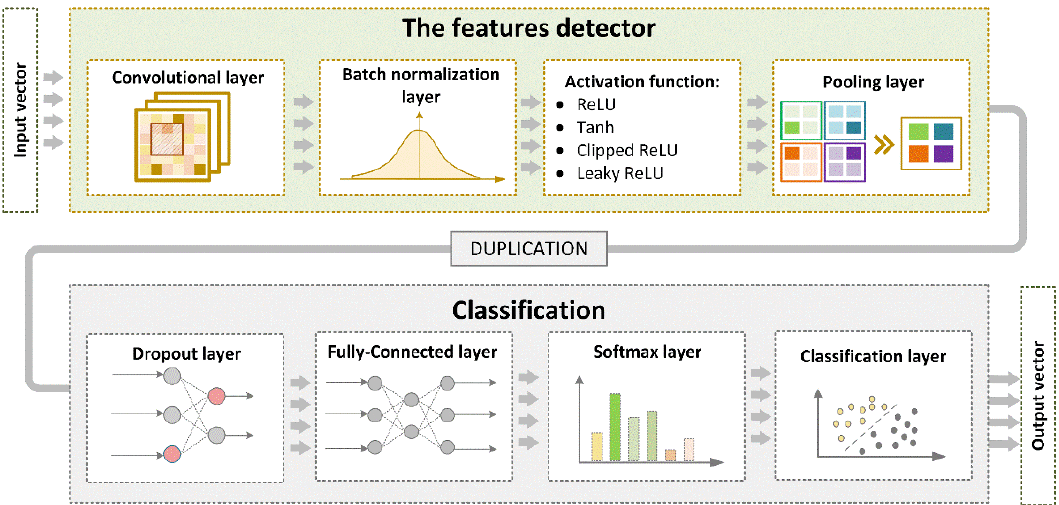
Figure 1. Structure of the CNNs used in the research.